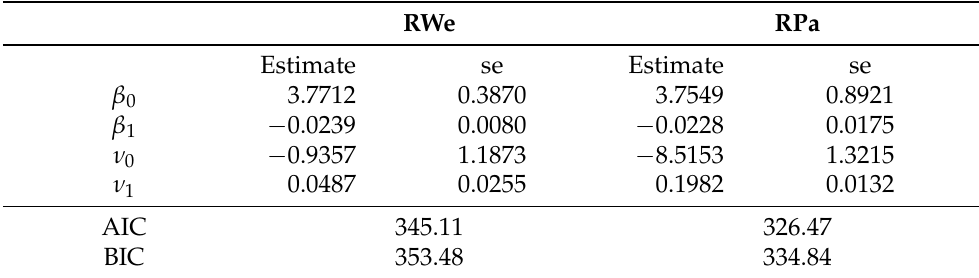
Table 3. Estimated parameters in metropolitan areas of USA data